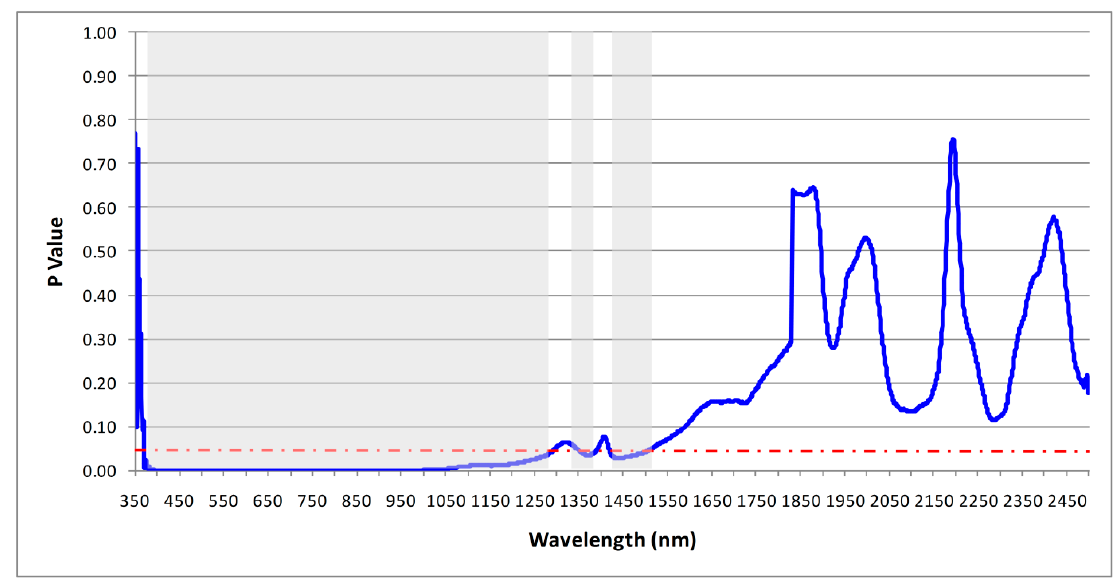
Figure 9. Wavelength-intervals shaded grey depict statistically significant differences between the lab-based spectra. The red-dashed line denotes the limit for statistical significance (95% confidence level).